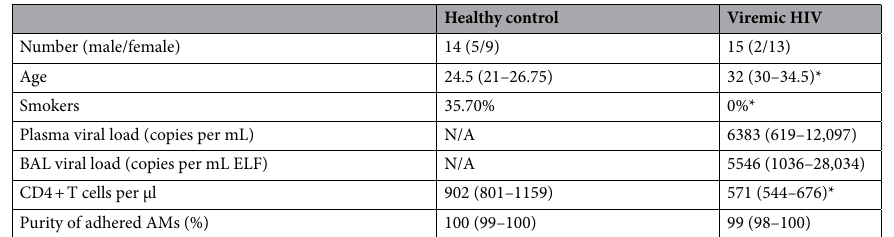
Table 1. Characteristics of participants in the Cape Town cohort. All participants were antiretroviral therapy- naive and were sensitized to Mycobacterium tuberculosis as determined by QuantiFERON TB Gold test without clinical or radiographic evidence of active TB. BAL, bronchoalveolar lavage; ELF, epithelial lining fluid; AM, alveolar macrophage. Values are expressed as median with interquartile range. Statistical analysis was performed with Mann–Whitney test, except for smokers, where Fisher’s exact test was performed. * p < 0.05 compared to healthy